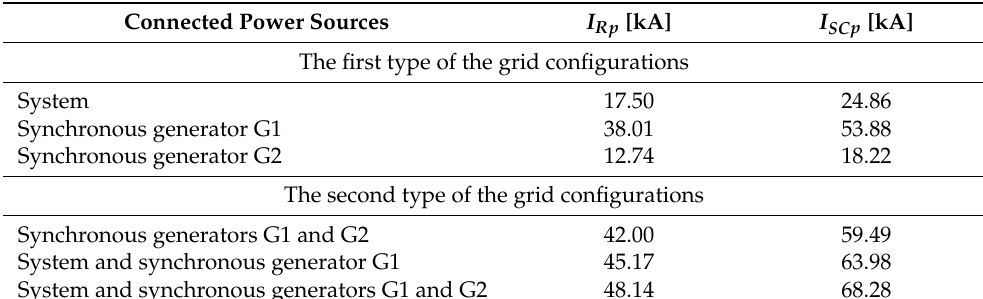
Table 3. Maximum current peaks in the reactor SR2 coils ( I Rp ) and at the short circuit point I SCp